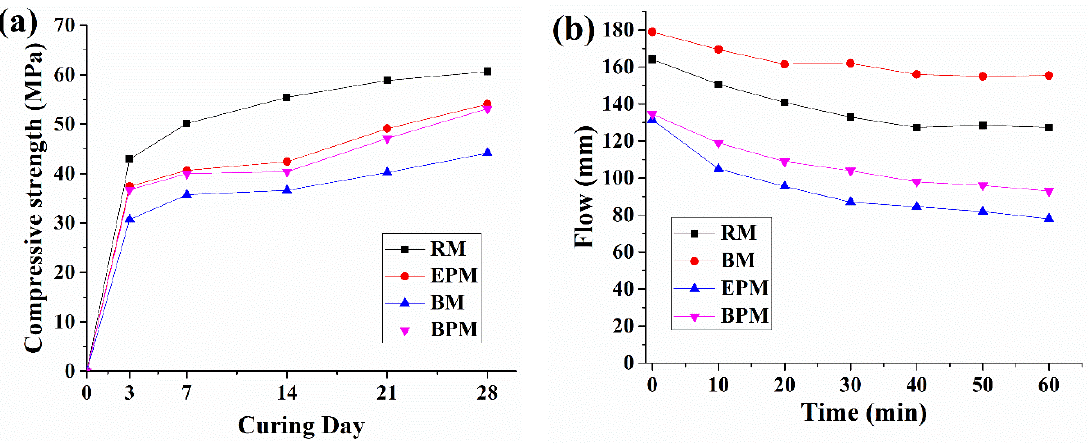
Figure 9. Compressive strength ( a ) and flow ( b ) of mortar specimens at curing days 3, 7, 14, 21 and 28.